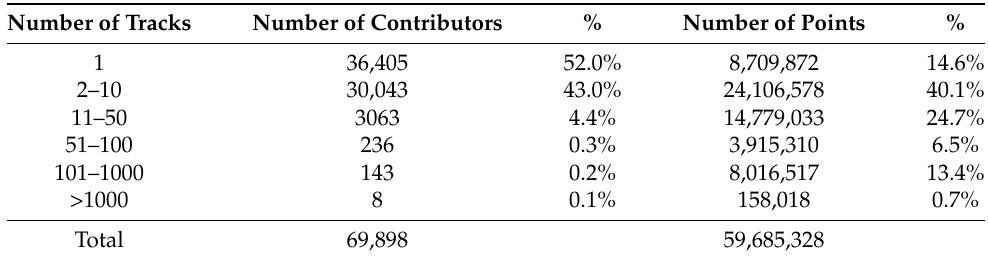
Table 7. Distribution of the number of contributors in function of the number of track measurements. The number of corresponding points is also